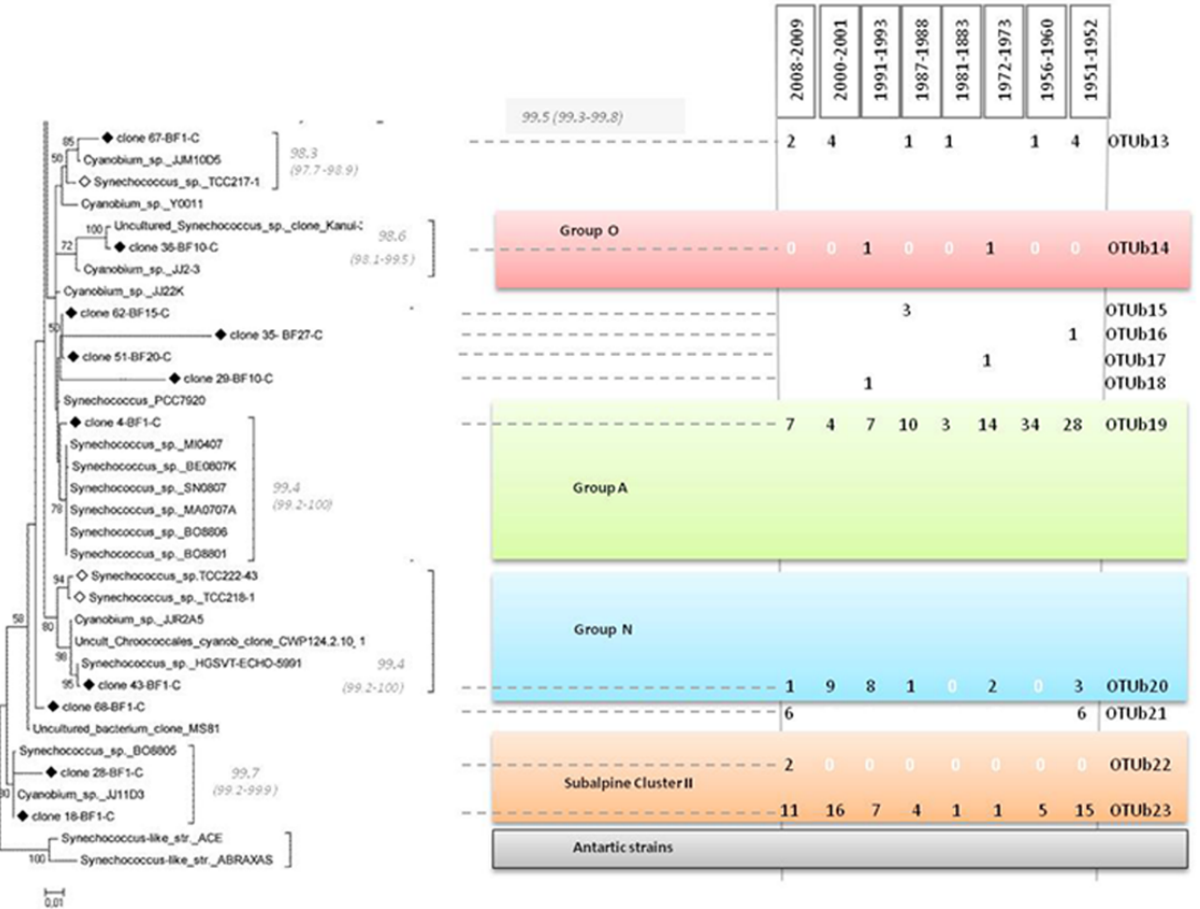
Fig. 4b. The left part present the ML phylogenetic tree obtained from partial 16S rRNA gene sequences (1100bp alignment). Sequences from sediments (black diamond), sequences from Synechococcus strains in Thonon Culture Collection (TCC; white diamond) and sequences from GenBank database (no specific sign) were used in this phylogenetic analysis. One representative clone was selected for each of the 23 OTUs identified from the sediment